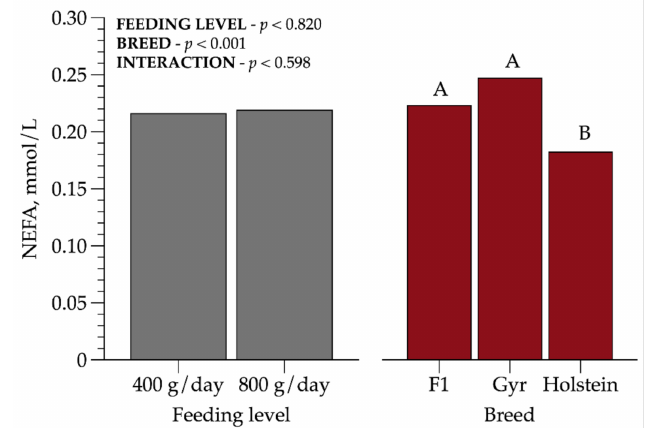
Figure 2. Plasma non-esterified fatty acid (NEFA) concentrations in prepubertal dairy heifers of three breed compositions (BCs) at two feeding levels (FLs). Values that differ significantly ( p < 0.05) are noted with different letters (A, or B). n =